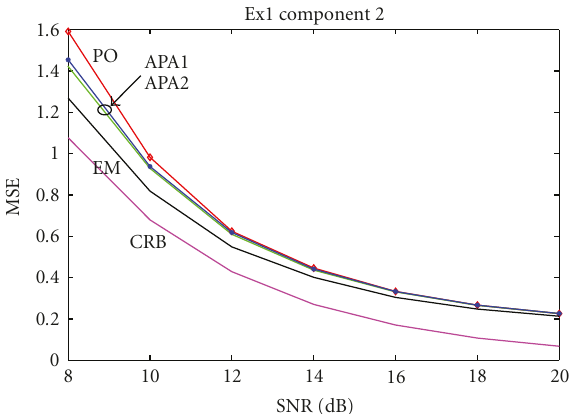
Figure 4: Experimental MSE versus SNR for Ex1 component 2.